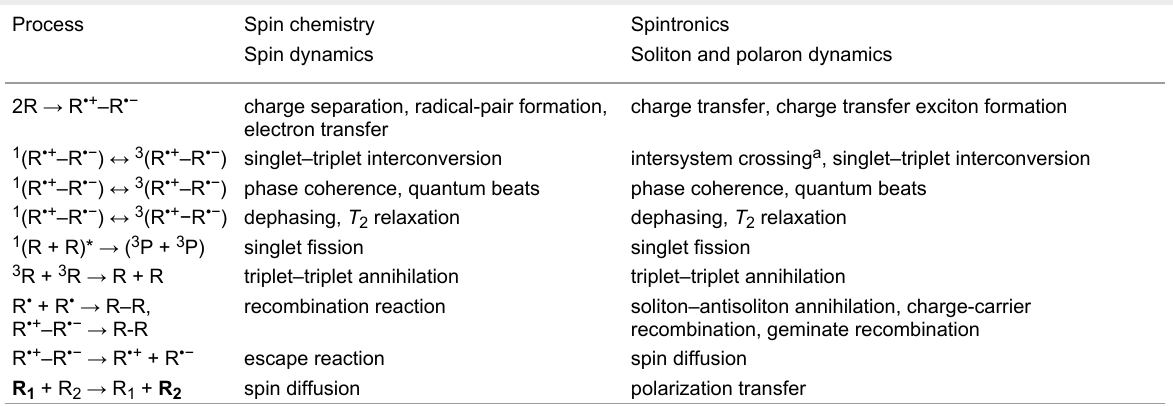
Table 2: Comparison of terminology and processes in spin chemistry and spintronics.